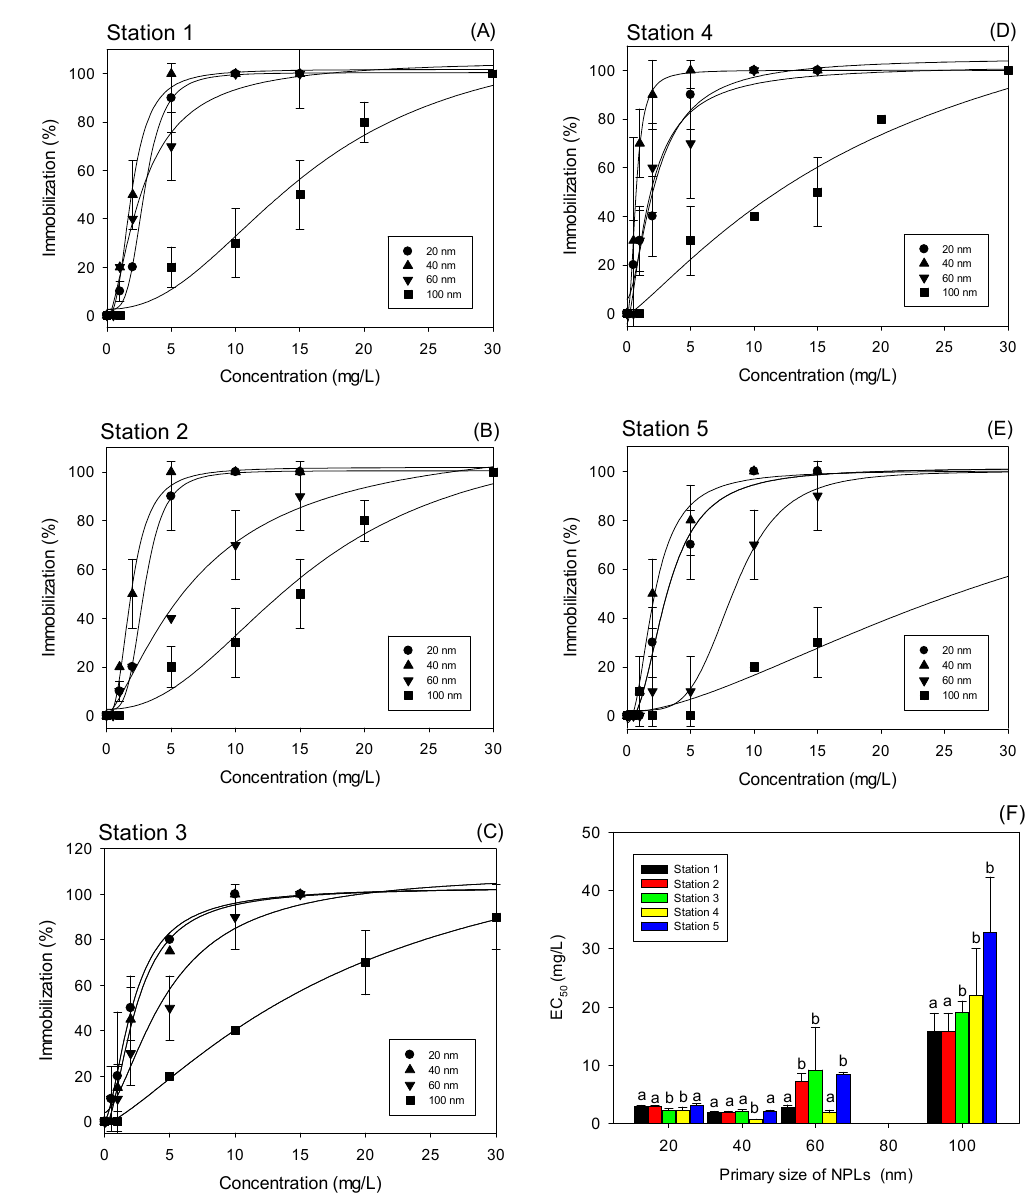
Figure 3. Dose–response (immobilization of D. magna ) curves obtained during 48-h exposure in water from different sampling stations in marsh–lake transect ( A – E ). The lines represent the fit of experimental data with a four-parameter log-logistic model. Error bars represent the standard deviation when bigger than the symbol size, N = 3. ( F ) Acute EC 50 values for D. magna , 48-h immobilization test, exposed to NPLs of different primary sizes obtained in natural water. Letters indicate statistically significant difference between treatments (pairwise multiple comparison procedures—Tukey’s test within each NPL size group, p -value < 0.05).